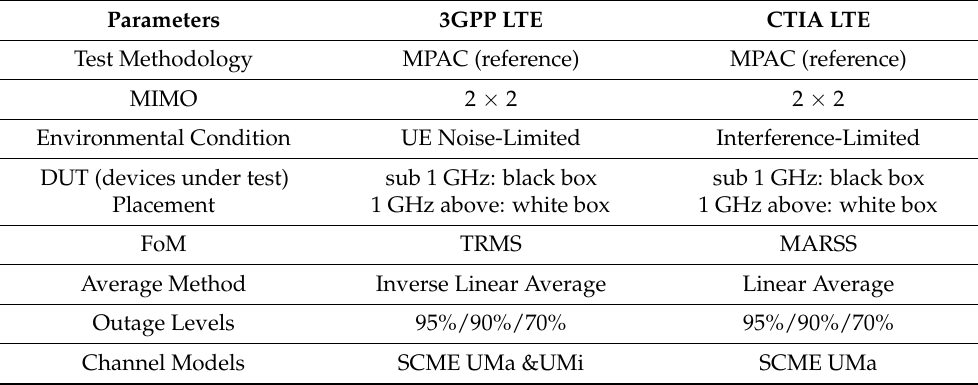
Table 1. A comparison of MIMO OTA methods in 3GPP and